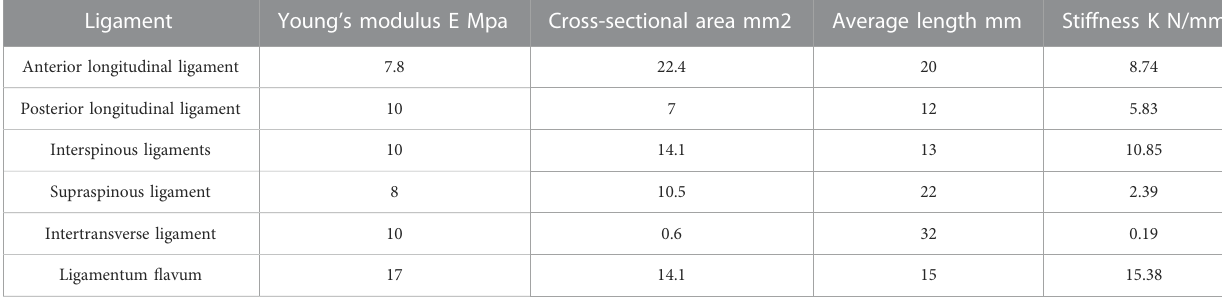
TABLE 2 Material properties of each ligament as